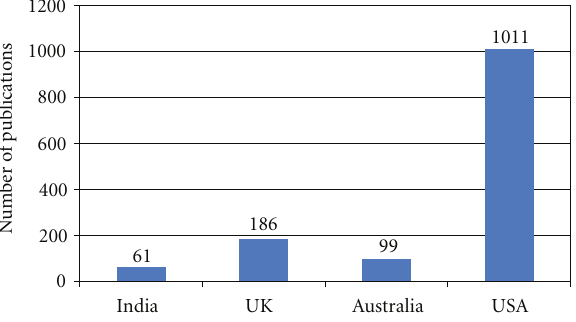
Figure 2: Publications on PHPT: India versus